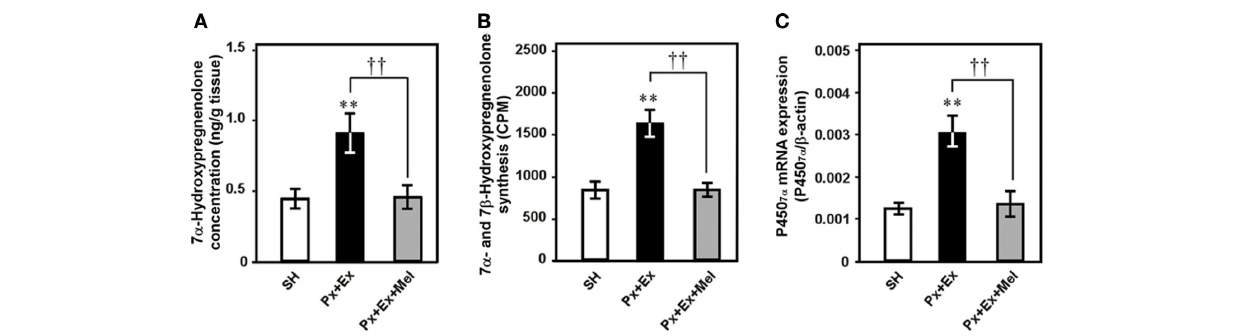
FigurE 6 | Effects of pinealectomy combined with orbital enucleation (Px + Ex) and melatonin administration to Px + Ex quail (Px + Ex + Mel) on 7 α -hydroxypregnenolone concentration, 7 α - and 7 β -hydroxypregnenolone synthesis, and P450